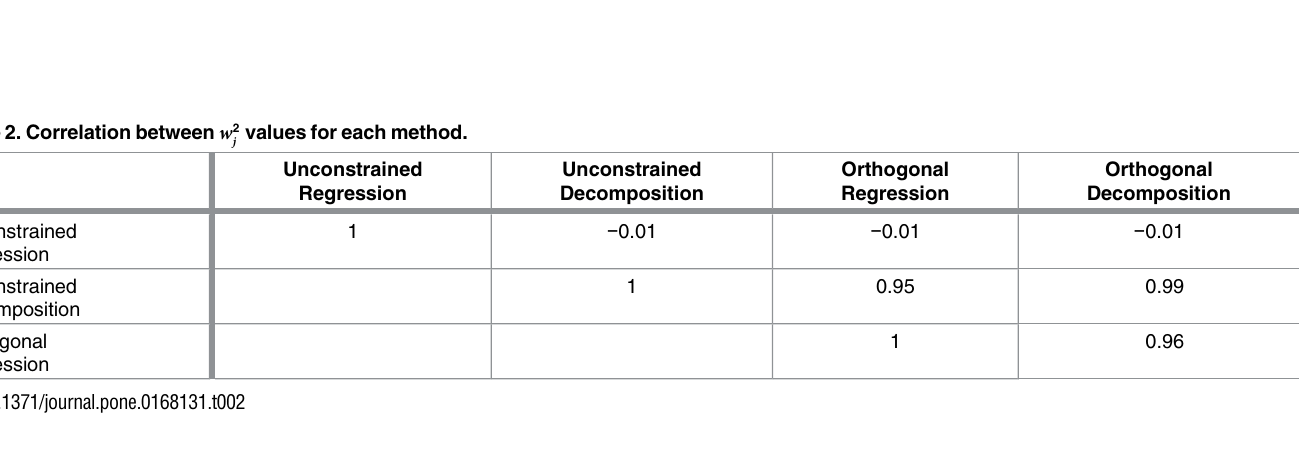
Table 2. Correlation between w 2